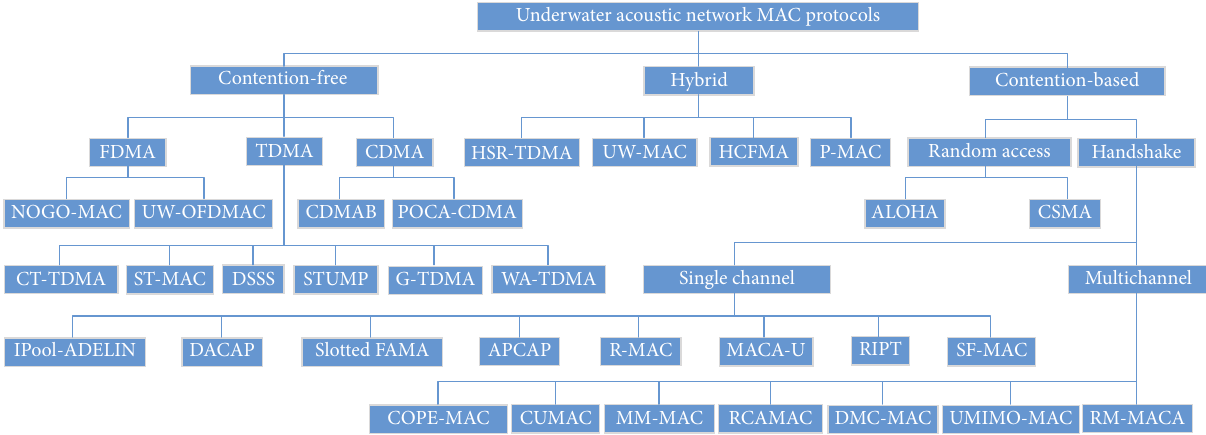
Figure 1: Most researchers classify underwater acoustic network MAC protocols into 3 types: contention-free, contention-based, and hybird.